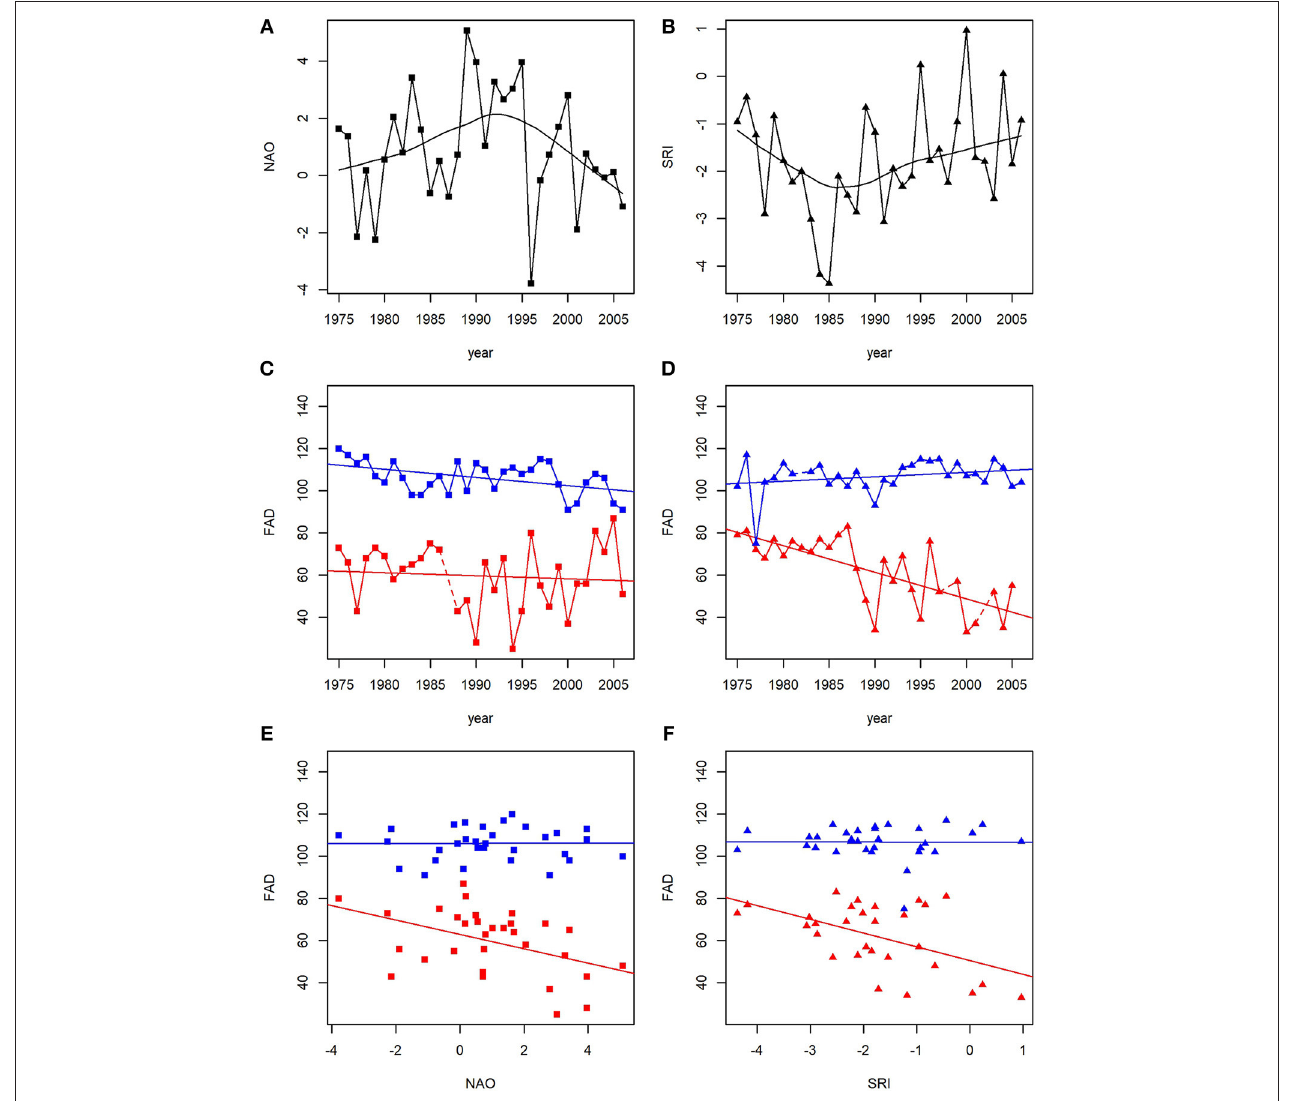
FIGURE 1 | Variation over time in (A) average winter (December to March) values of NAO, (B) average rainy-season (June to October) values of SRI, and (C–F) first arrival dates (FAD; number of days since 1 January). Examples are shown for FAD as function of year (C–D) , NAO (E) , and SRI (F) in four species as follows: red squares, strong NAO responsiveness (gadwall Anas strepera ); blue squares, weak NAO responsiveness (black tern Chlidonias niger ); red triangles, strong SRI responsiveness (Eurasian marsh harrier Circus aeruginosus ); blue triangles, weak SRI responsiveness (Eurasian reed warbler Acrocephalus scirpaceus ). LOESS curves are fit for NAO and SRI (A,B) to illustrate their non-linear changes during the study period. For FAD (C–F) , linear regressions are fit to illustrate slopes. To illustrate year-to-year variation (A–D) , consecutive data points are connected by solid lines; dashed lines indicate gaps in the time